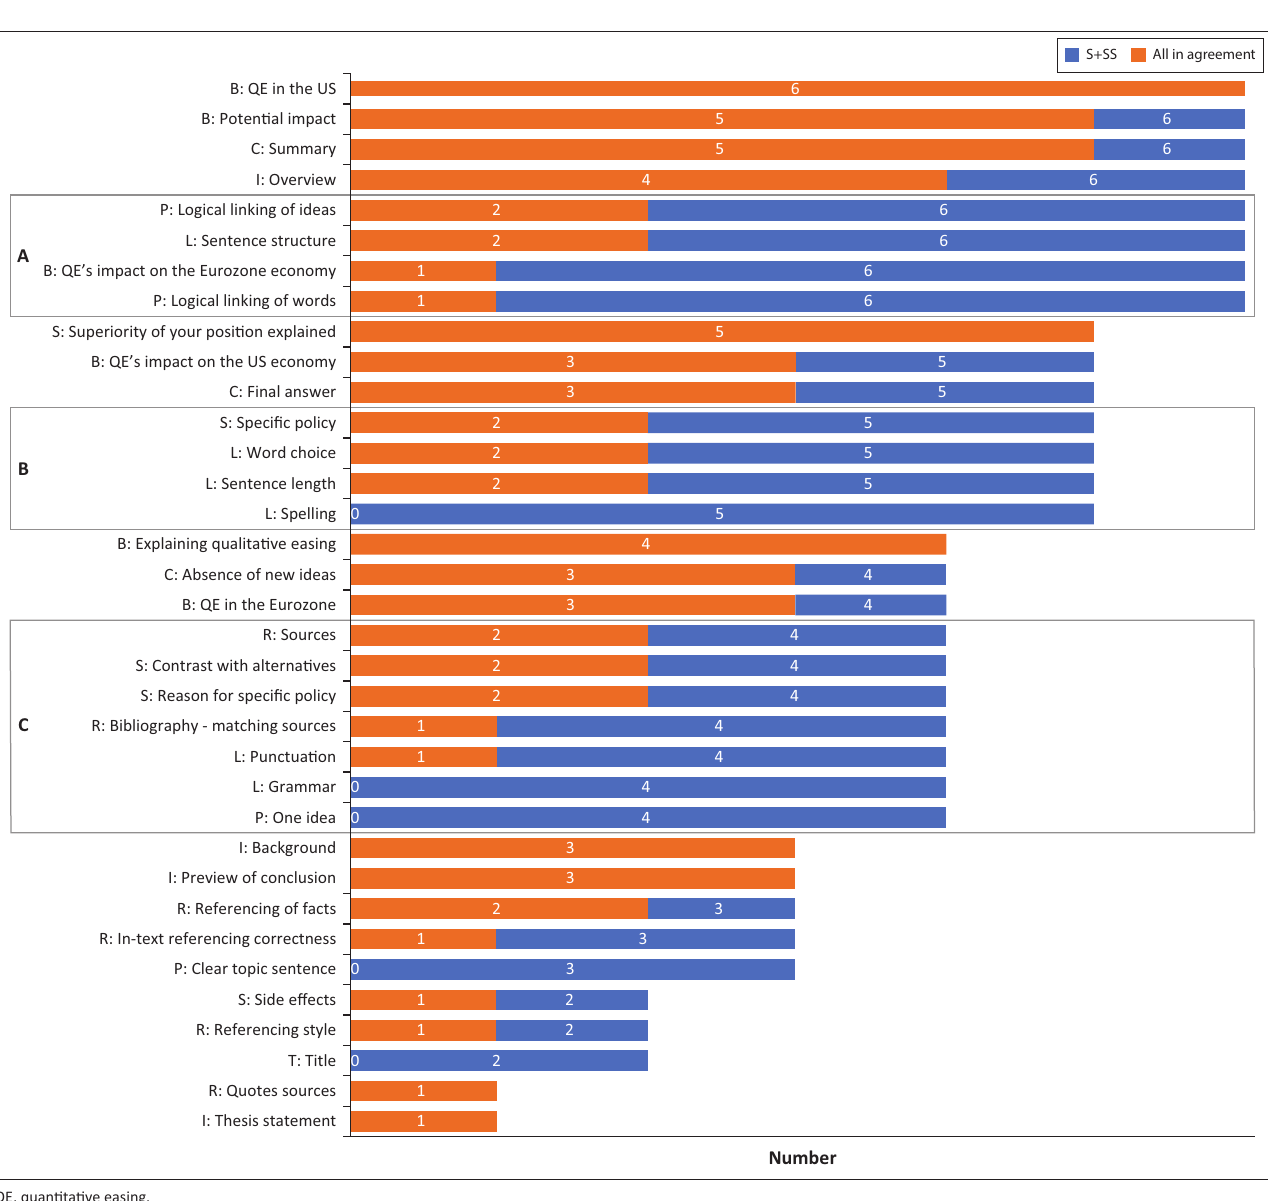
FIGURE 4: The number of cases in which there is an agreement on each topic in all six student documents between the student (S) and the subject specialist (SS) (blue) where the number of all evaluators are in agreement (orange) plotted against the topics that were evaluated in the eight different